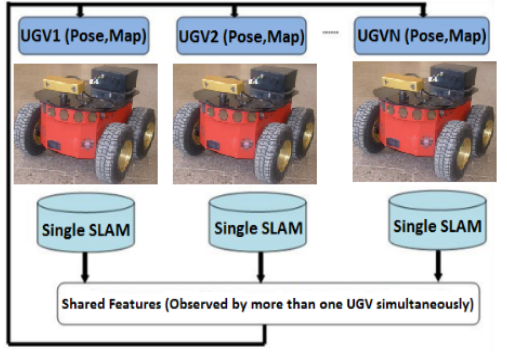
Fig. 2: Decentralized Cooperative SLAM architecture.